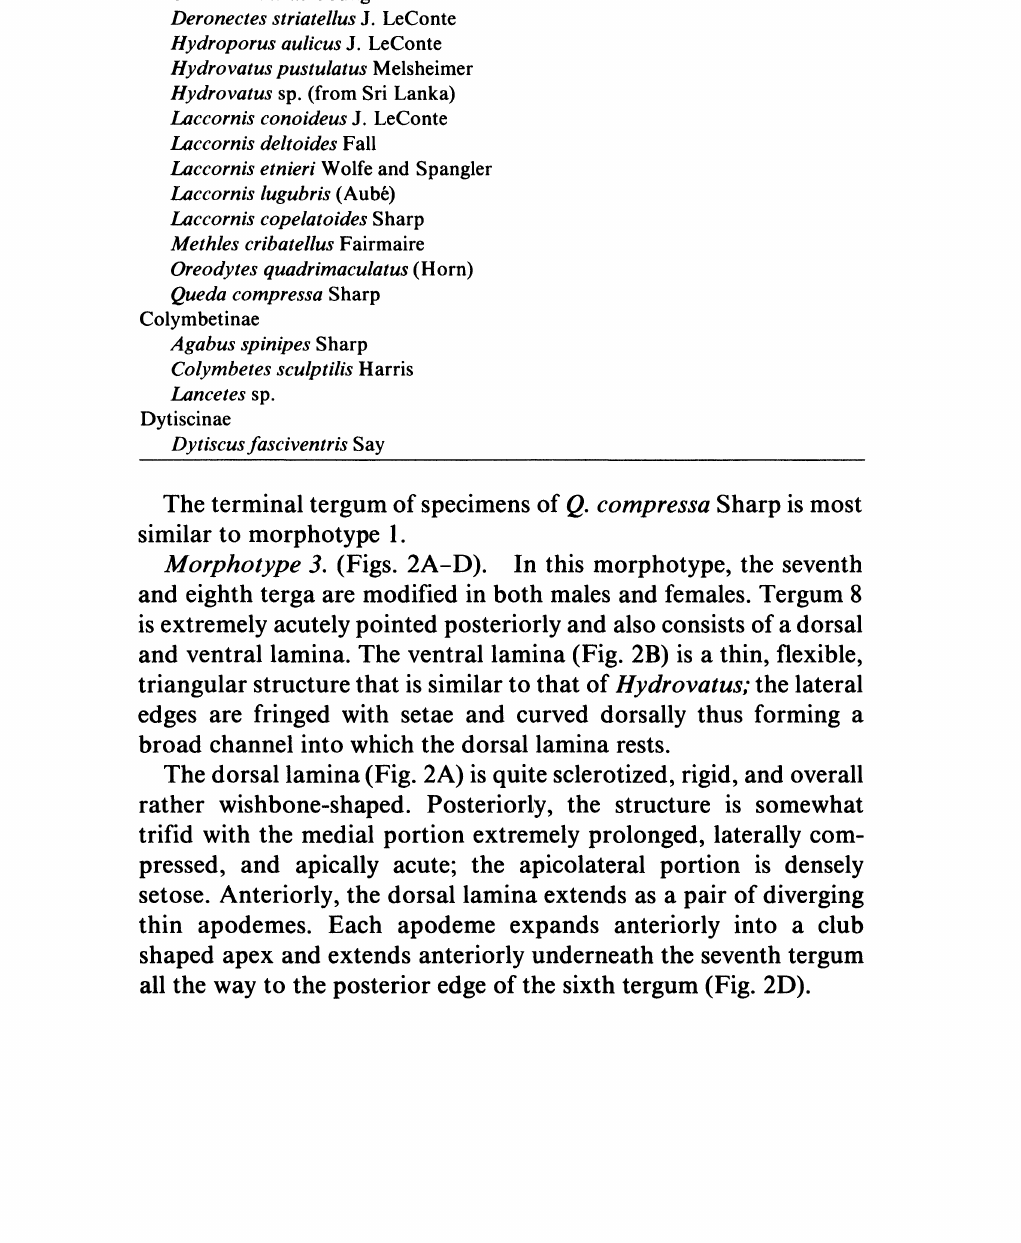
Table 1. List of species of Dytiscidae examined only for abdominal structure. Hydroporinae Canthyporus hottentotus Gemminger and Harold Celina grossula J. LeConte Celina hubbelli Young Celina imitatrix Young Deronectes striatellus J. LeConte Hydroporus aulicus J.